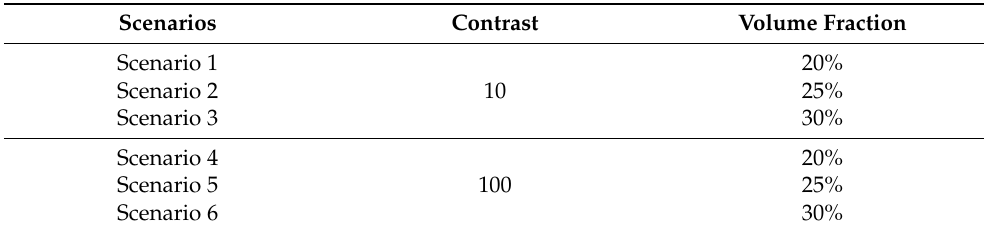
Table 1. The 6 different calculation scenarios to be tested, collected by modifying the contrast and the volume fraction. Scenarios Contrast Volume Fraction Scenario 1 20% Scenario 2 10 25% Scenario 3 30% Scenario 4 20% Scenario 5 100 25% Scenario 6